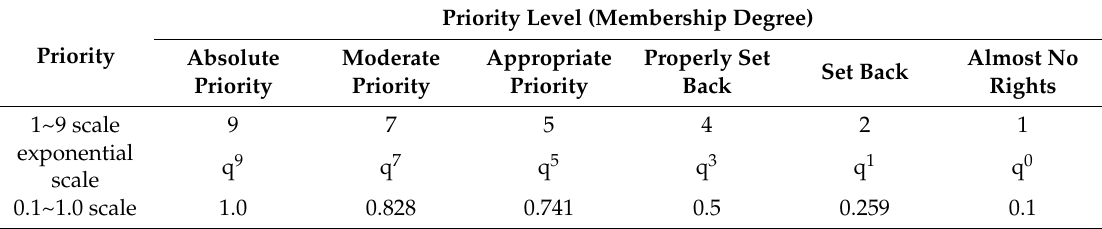
Table 2. Evaluation index scale